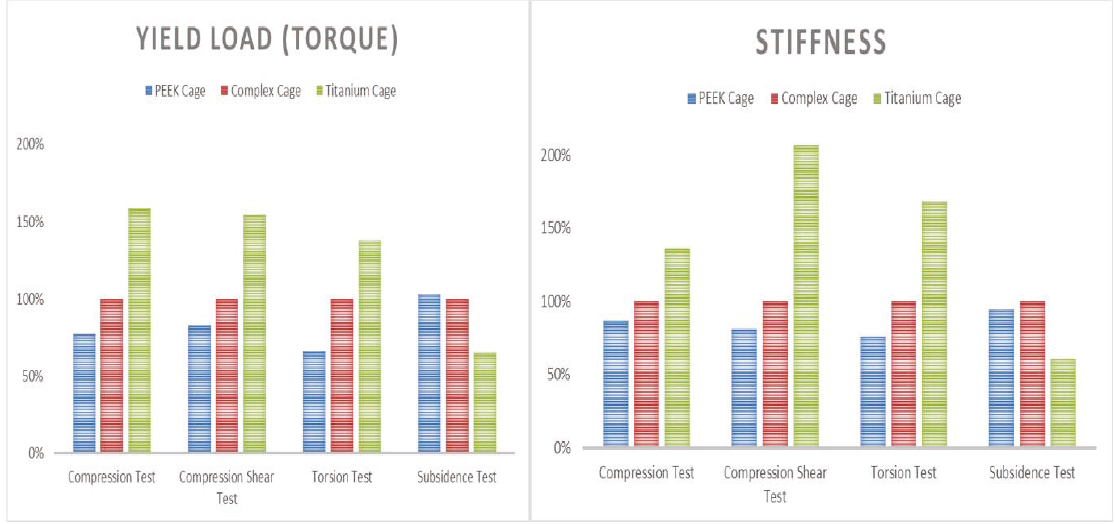
Figure 10. Average result of performance test (left yield load and right stiffness).